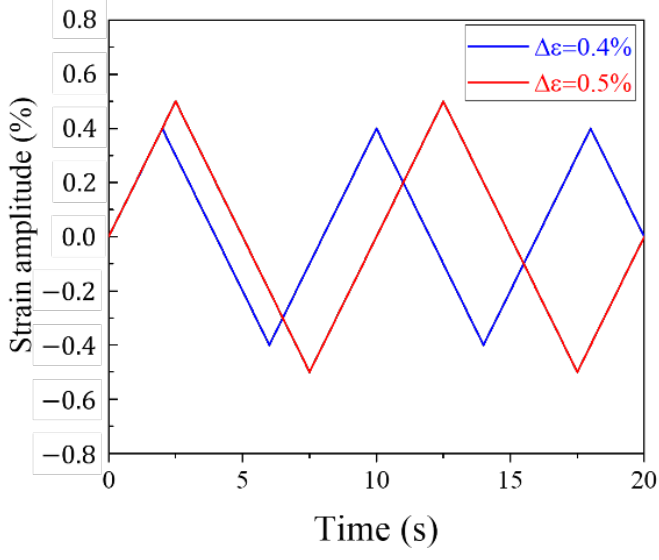
Figure 2. Strain amplitude for the LCF test.